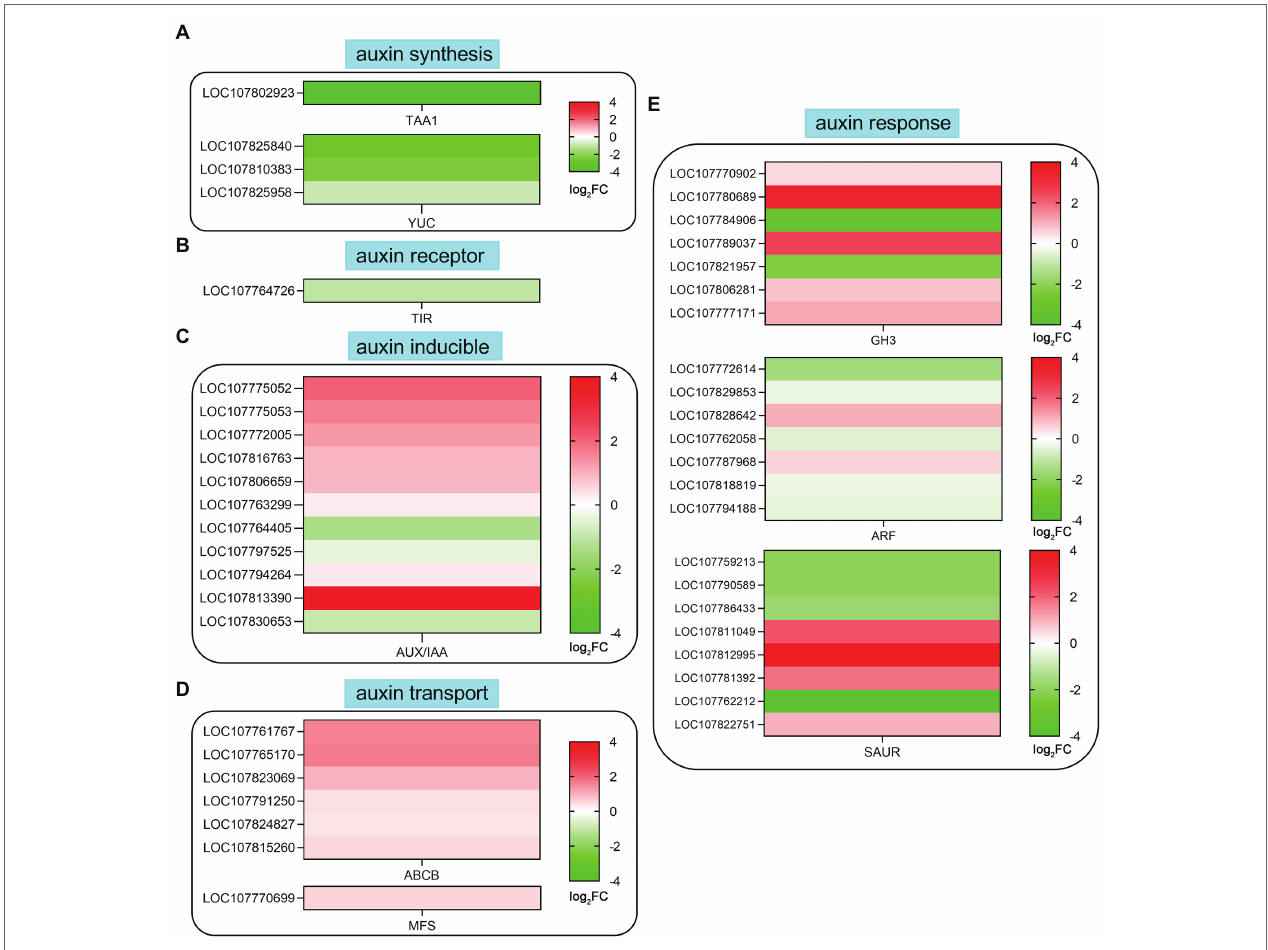
FIGURE 7 | Effects of SHAM treatment on the gene expression of auxin biosynthesis and signaling transduction pathway. DEGs related to auxin biosynthesis (A) , auxin receptor (B) , auxin inducible (C) , auxin transport (D) , and auxin response (E) are shown. TAA1, tryptophan aminotransferase; TIR1, transport inhibitor response 1; ABP, auxin binding protein; SAUR, small auxin-up RNA; ABCB, ABC transporter B family member; MFS, multidrug resistance protein; GH3, indole-3- acetic acid-amido synthetase GH3; and ARF, auxin response factor. log 2 FC, log 2